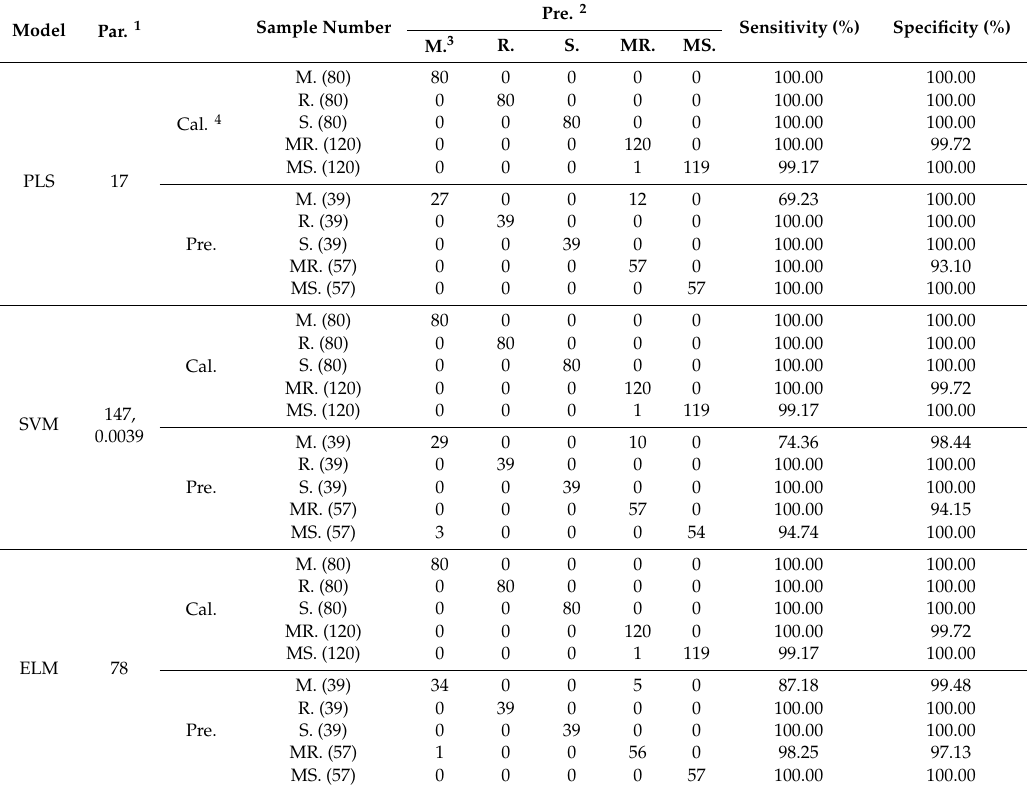
Table 2. Confusion matrix of models using full